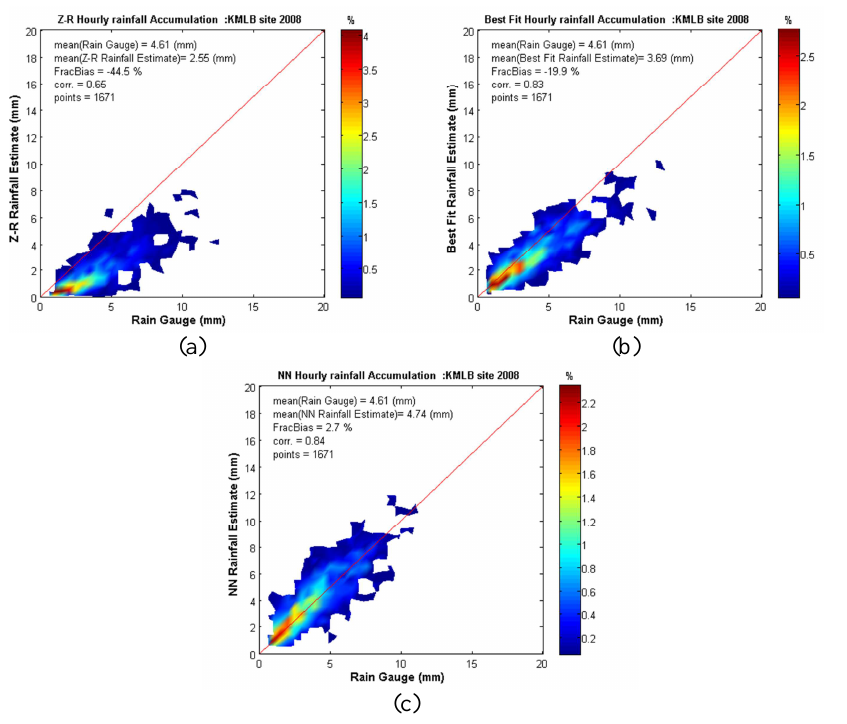
Fig. 8. Actual rain gauge vs. (a) Z – R estimate (b) best-fit estimate and (c) NN estimate. Data from year 2008 over KMLB. (Hourly rainfall accumulation).